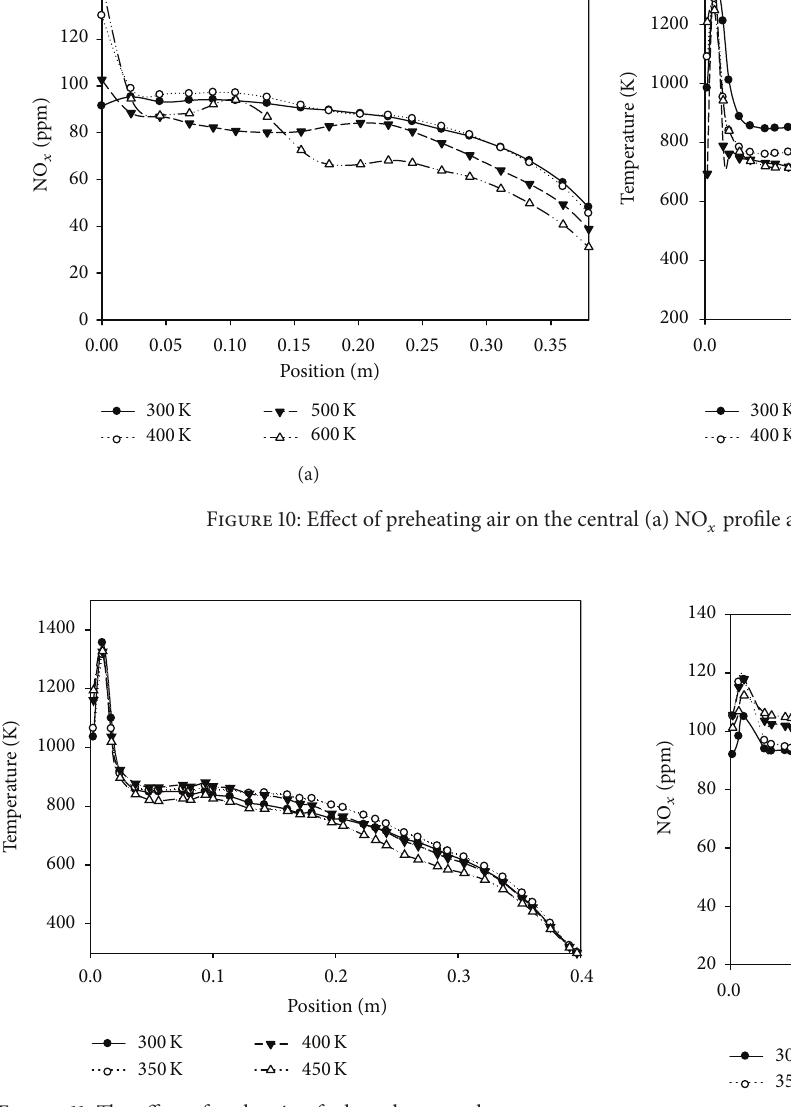
Figure 12: The effect of preheating fuel on the central NO 𝑥